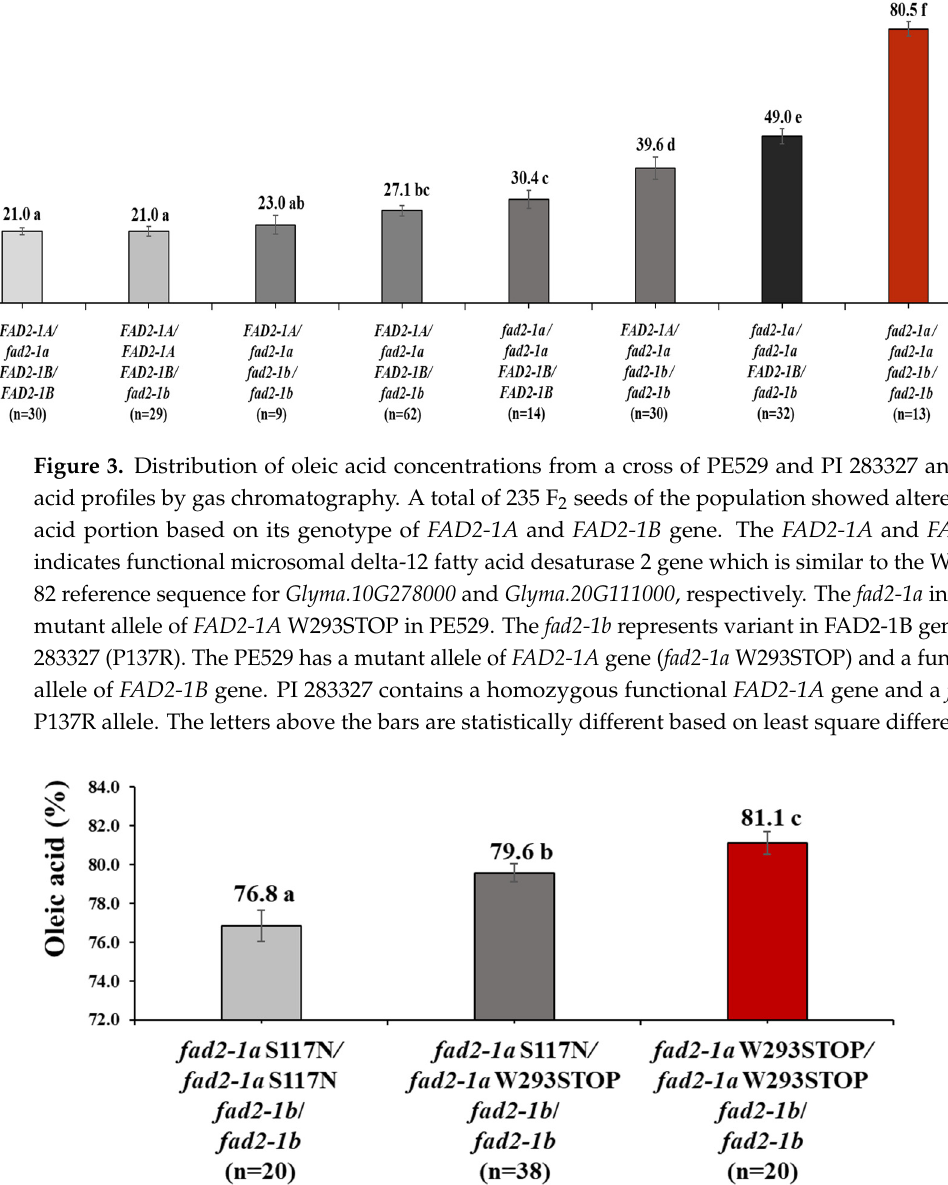
Figure 4. Oleic acid content based on the genotype of FAD2-1 genes from a cross of Hosim and PE529. A total of 288 F 2 seeds were investigated for fatty acid profiles. Individuals with approximately 80.0% oleic acid based on gas chromatography analysis were selected. A total of 78 individuals were genotype with a FAD2-1A S117N allele from 17D, a FAD2-1A W293STOP allele from PE529, and a FAD2-1B P137R allele from PI 283327. The FAD2-1A and FAD2-1B indicates functional microsomal delta-12 fatty acid desaturase 2 gene which is similar to the Williams 82 reference sequence for Glyma.10G278000 and Glyma.20G111000 , respectively. The fad2-1a S117N indicates mutant allele of FAD2-1A in 17D. The fad2-1a W293STOP indicates mutant allele of FAD2-1A in PE529. The fad2-1b represents variant in FAD2-1B gene in PI 283327 (P137R). The PE529 has a mutant allele of FAD2-1A gene ( fad2-1a W293STOP) and a functional allele of FAD2-1B gene. Hosim contains fad2-1a S117 allele and a fad2-1b P137R allele. The letters above the bars are statistically different based on least square difference.